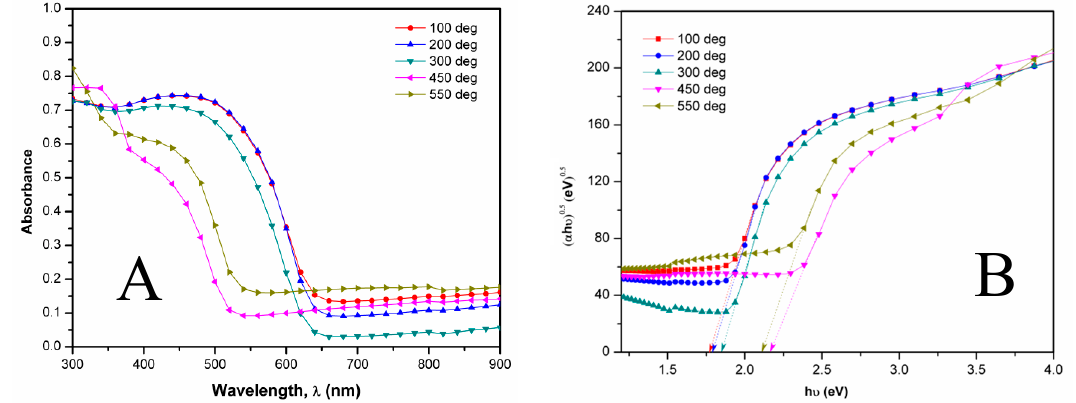
Figure 4. Absorbance spectra ( A ) and Tauc plot ( B ) of annealed BiOI at different temperatures.